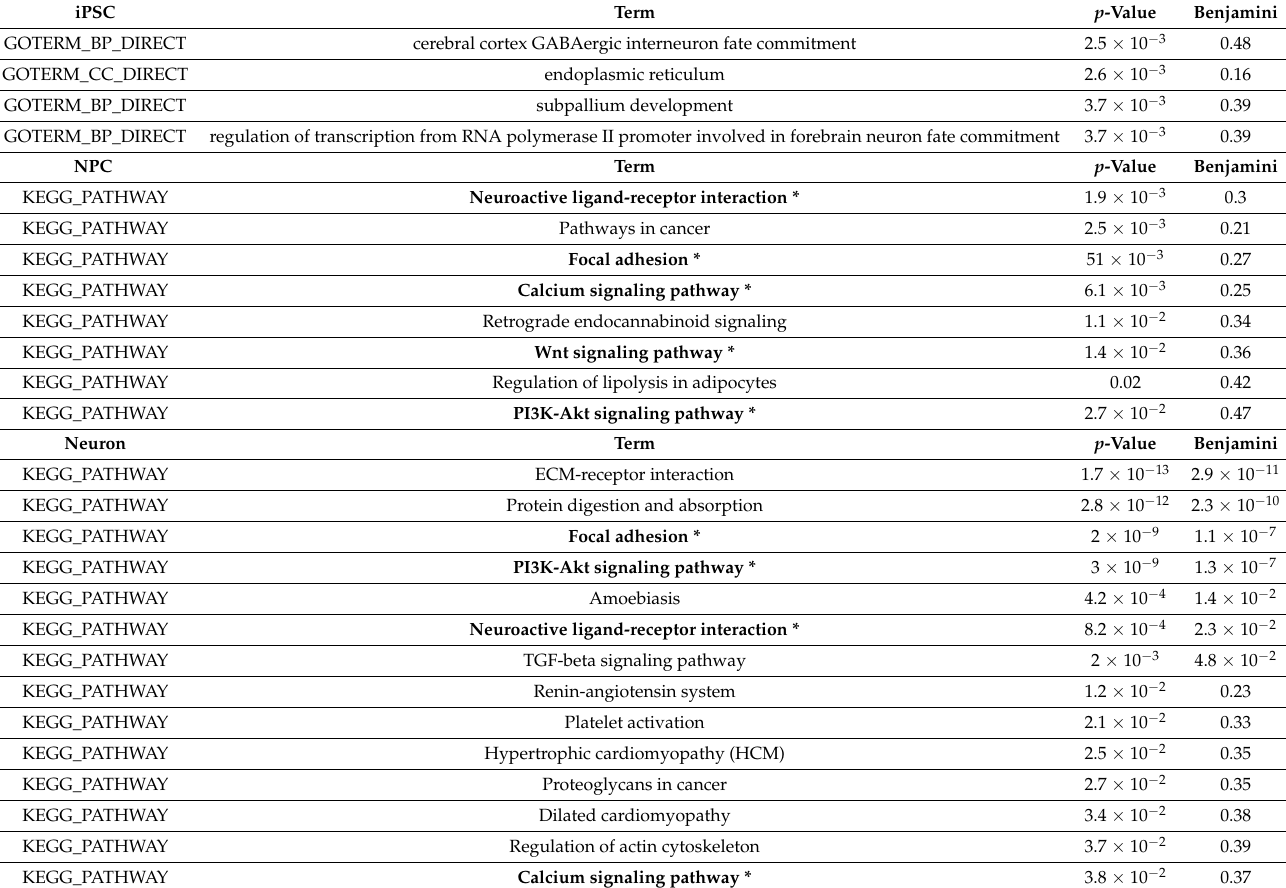
Table 1. Functional annotations of the DEGs of different cell types in neural system